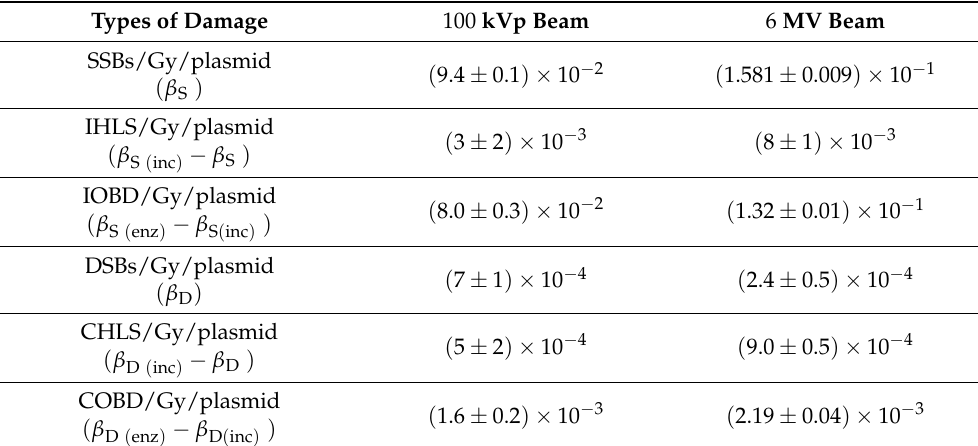
Abbreviations: Probability parameters representing the amount of DNA damage per Gy per plasmid for samples post irradiation ( β ) , post irradiation and incubation with no enzymatic treatment at 37 ◦ C for 1 h post irradiation and enzymatic treatment under incubation at 37 ◦ C ( β ( enz )